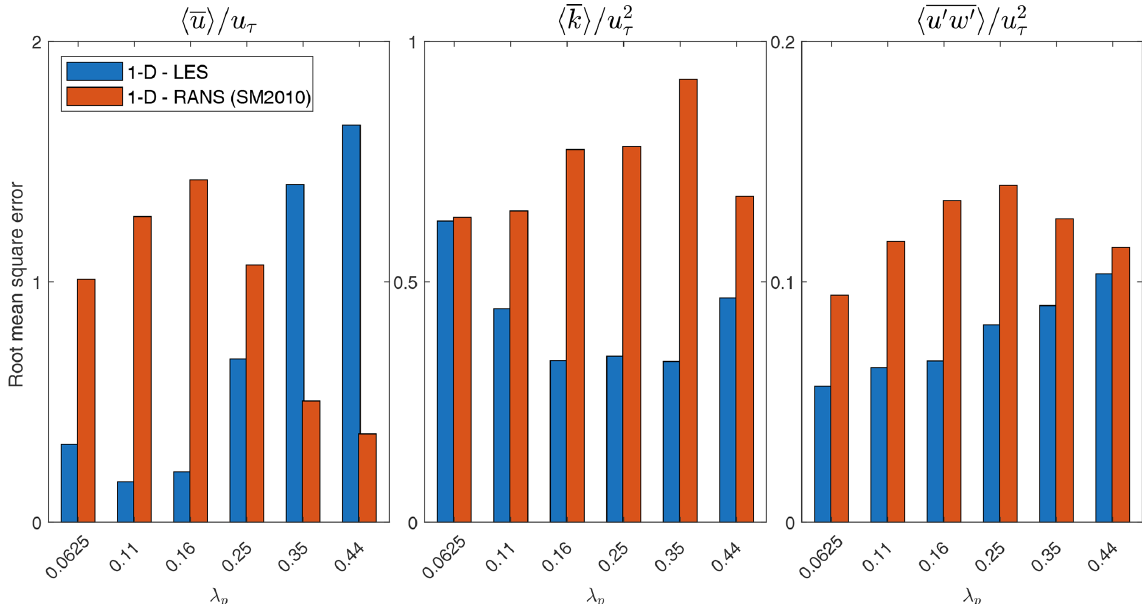
Figure 13. Root mean square error calculated for vertical profiles of velocity ( u values are calculated using 1-D models with LES and RANS parameterization up to 3 H .